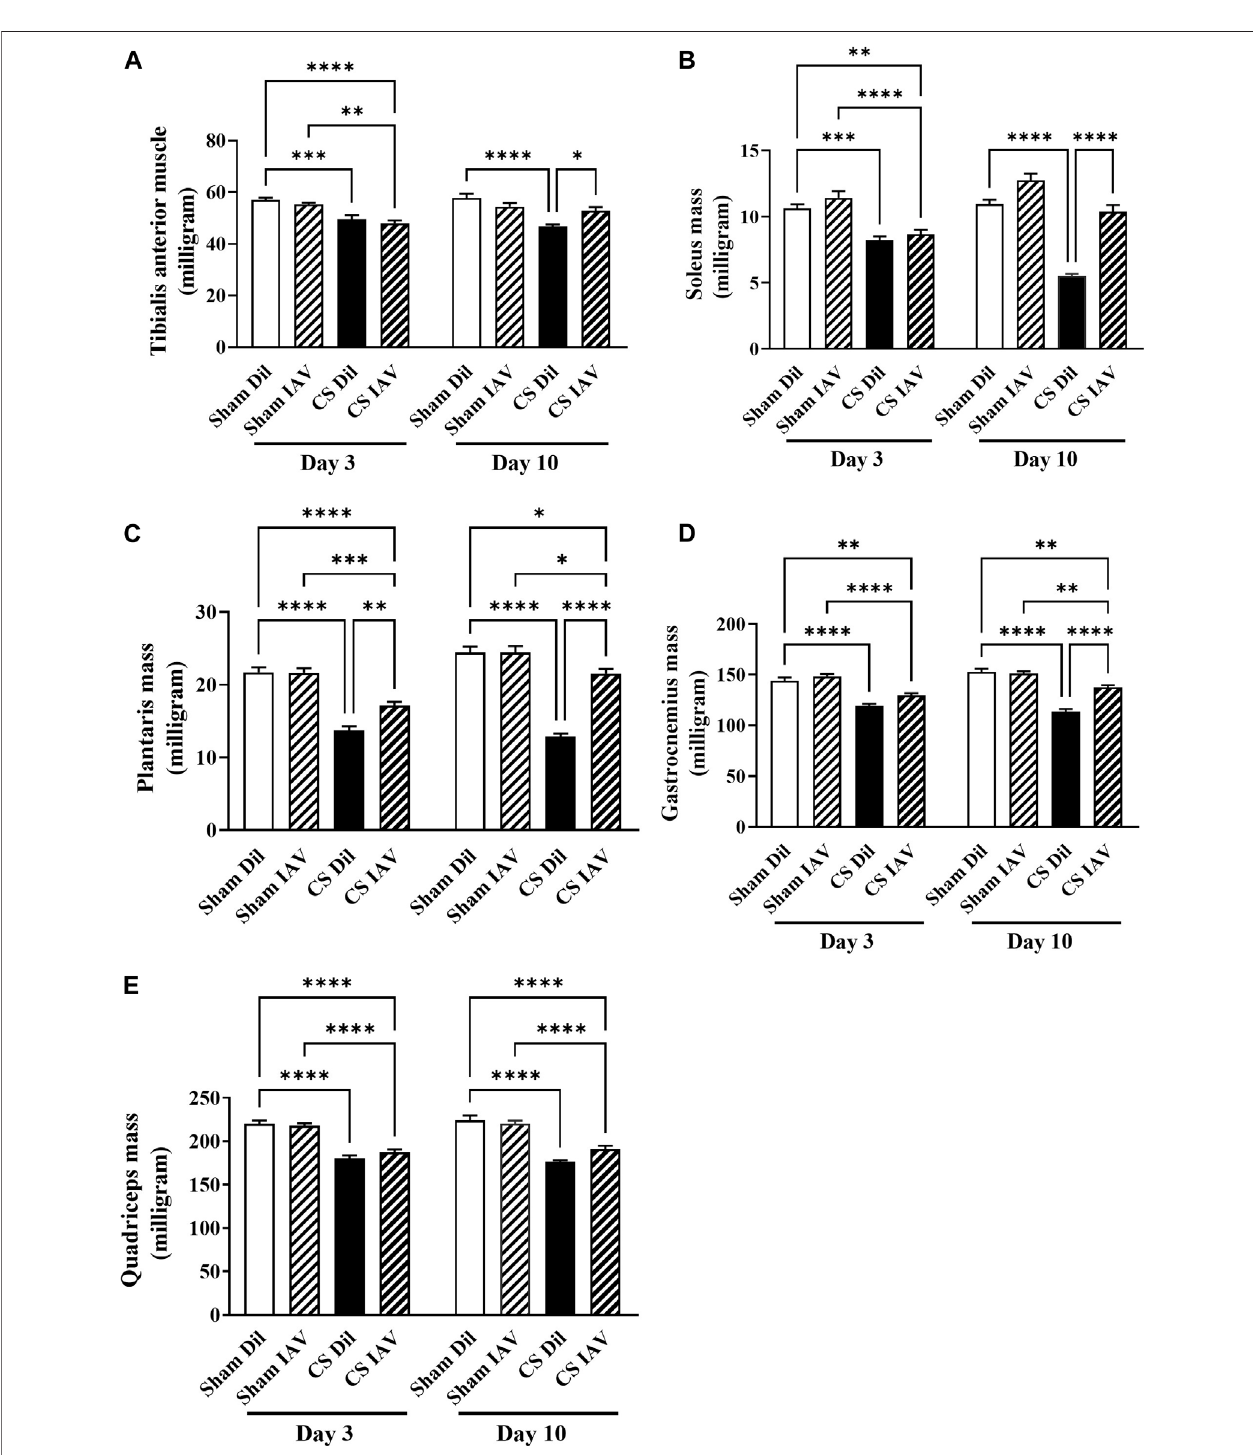
FIGURE 2 | Effectof CS exposure and in fl uenza A virus (IAV) infection on mass of hind limb muscles. The weight of the (A) tibialis anterior, (B) soleus, (C) plantaris, (D) gastrocnemius, and (E) quadriceps muscles from CS-exposed and Sham mice following IAV infection. Data shown as mean +SEM ( n = 14 per group). * p < 0.05, ** p < 0.01, *** p < 0.001, **** p < 0.0001.